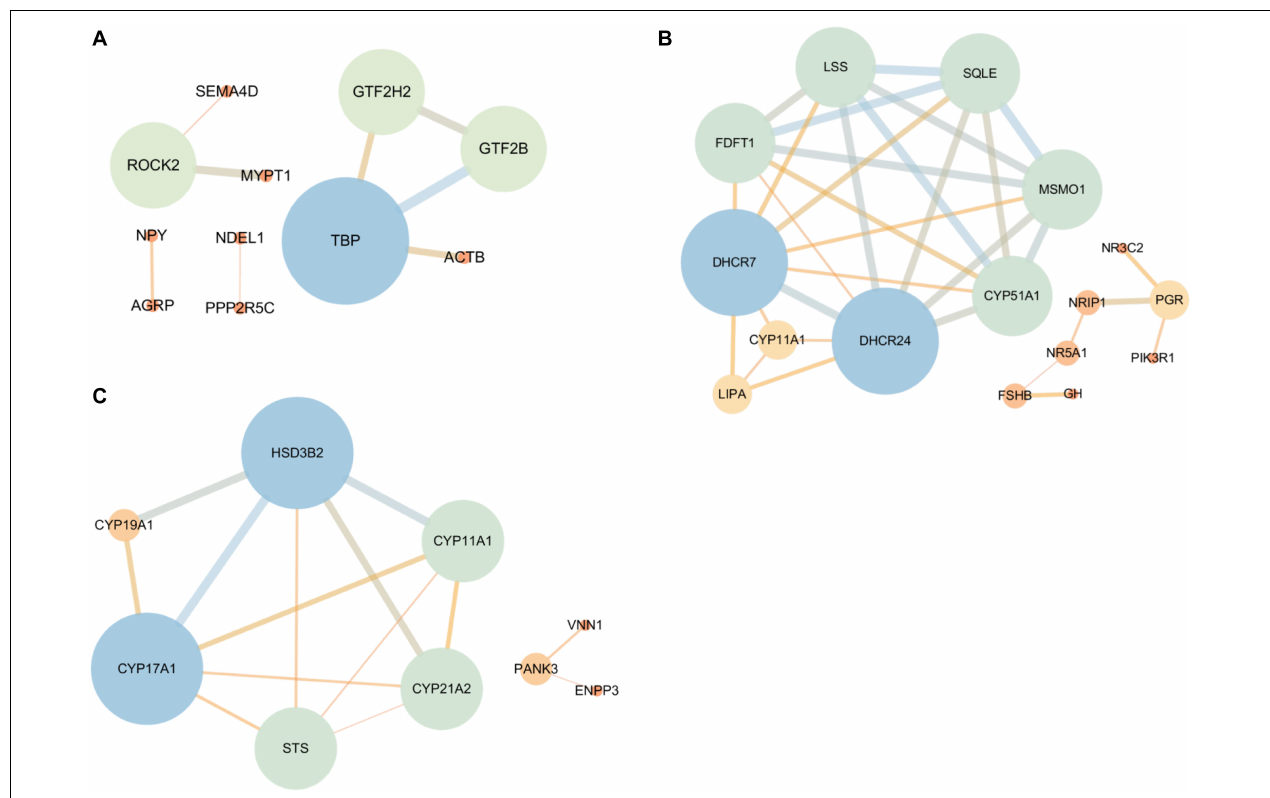
FIGURE 6 | The protein-protein interaction (PPI) network of the DEGs that are associated with HPO axis function according to the GO and KEGG analyses [ (A) Hypothalamic, (B) Pituitary, and (C) Ovary]. The bigger the node circle and the thicker the edges, the greater the connectivity among genes. The color gradient from blue to orange also corresponds with the connectivity among genes, indicating strong to weak,